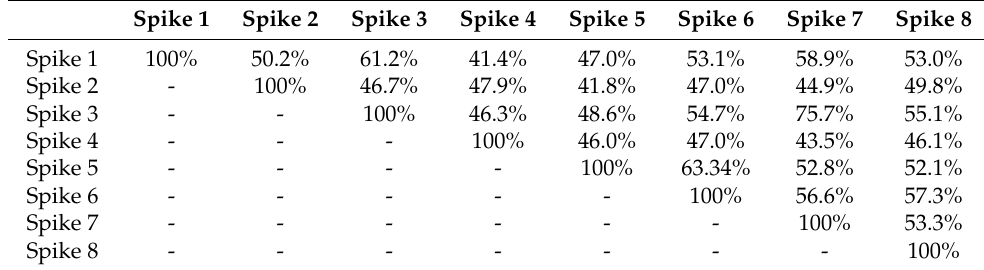
Table 2. Sequence identity matrix across capsid spike domains from human astrovirus serotypes 1– 8.